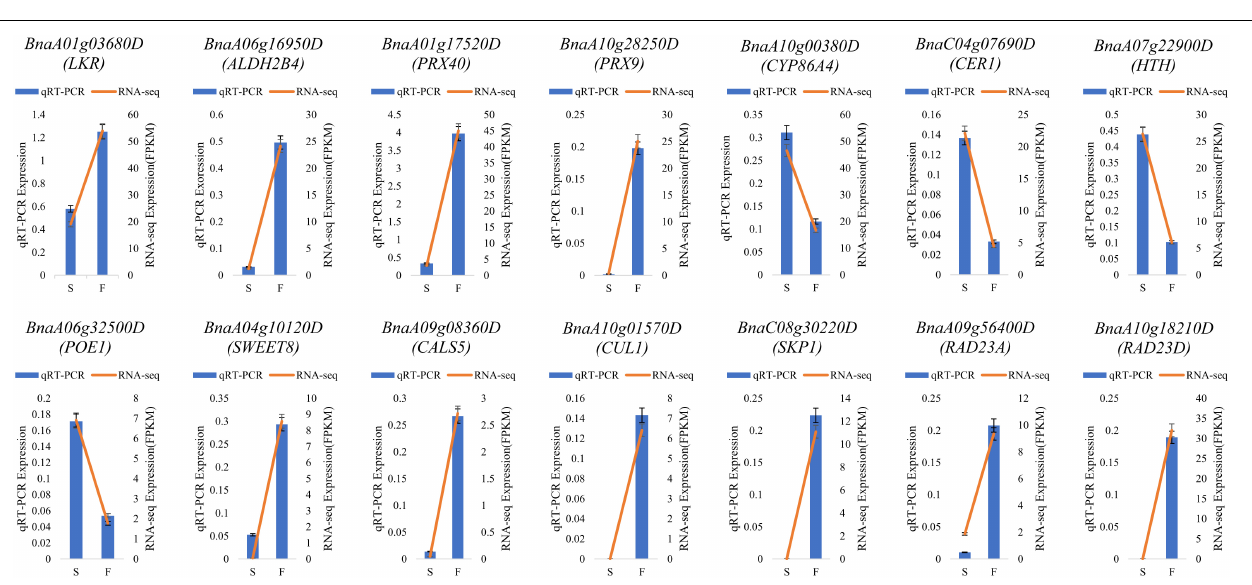
FIGURE 9 | Protein–protein interaction (PPI) network related to the regulator Rfw . Red and green indicate upregulated and downregulated differentially expressed genes [DEGs; the shade reflects log2(fold change)].